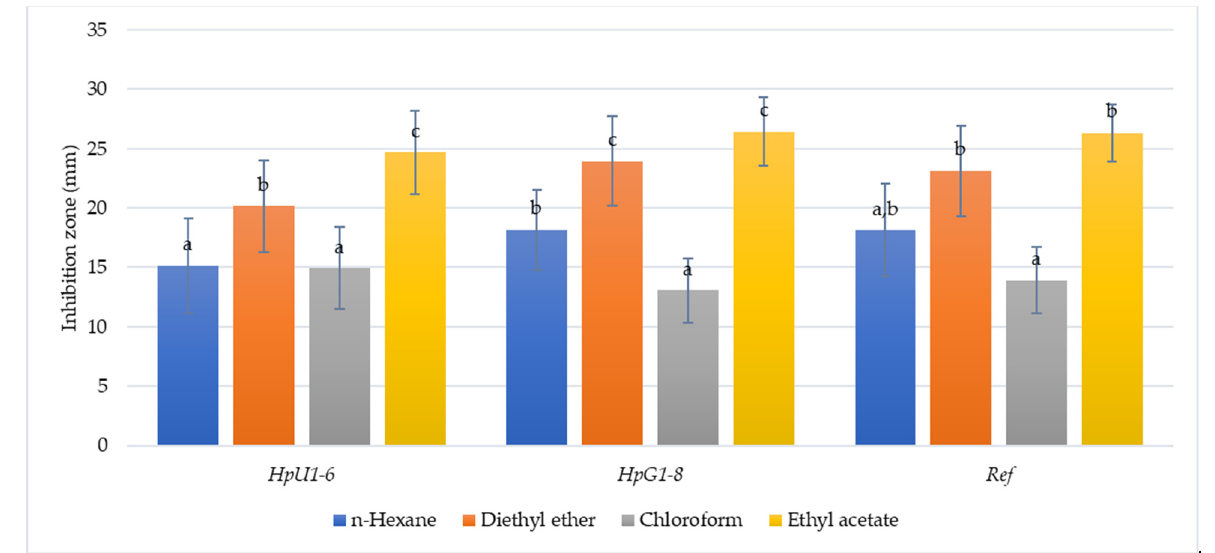
Figure 1. Mean diameter of inhibition zones from various solvent extracts against ulcer ( HpU1-6 , n = 6), gastritis ( HpG1-8 , n = 8), and the reference strain of H. pylori DSM21031. Different letters in bars indicate statistically significant differences (ANOVA with Tukey’s HSD, p < 0.05) for each group of strains.